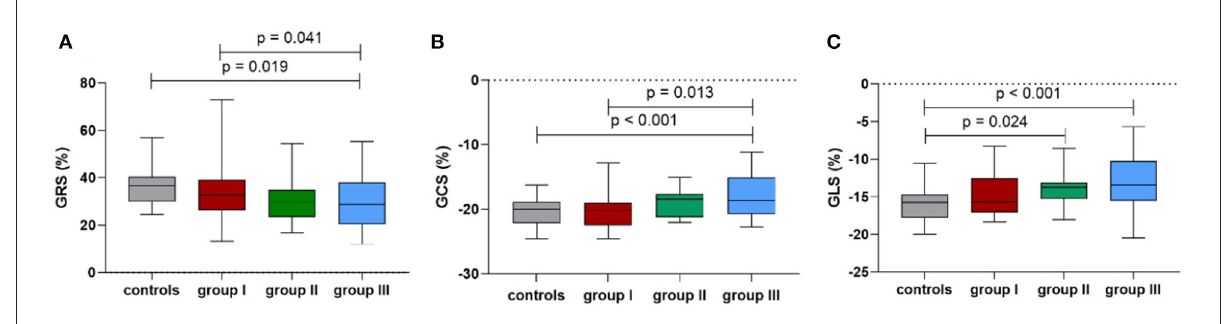
FIGURE3 Comparison of the mean peak global radial strain (A) , peak global circumferential strain (B) and peak global longitudinal strain (C) among the controls and groups I-III.